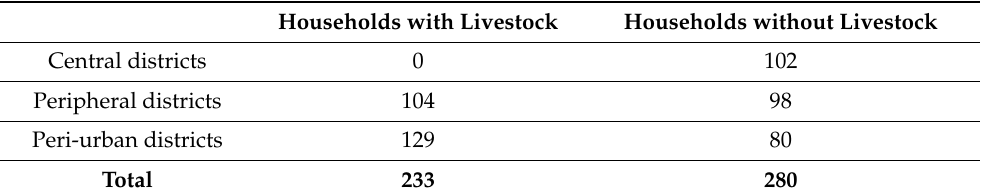
Table 1. The number of livestock-keeping households and non-livestock-keeping households in- cluded in the survey in Hanoi city, Vietnam. Households with Livestock Households without Livestock Central districts 0 102 Peripheral districts 104 98 Peri-urban districts 129 80 Total 233